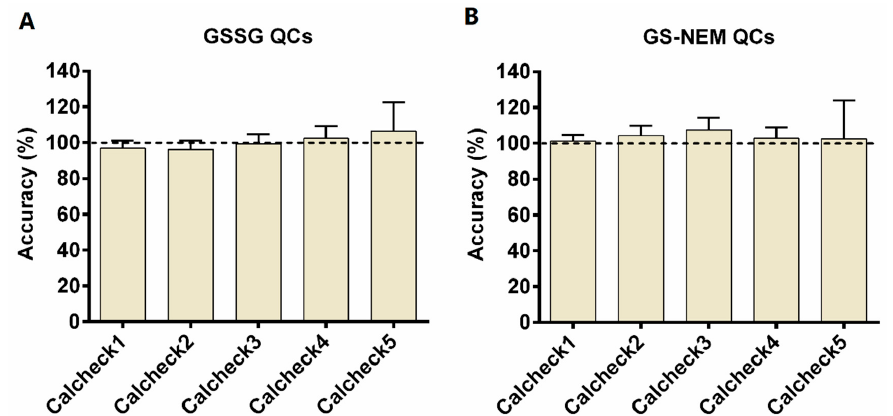
NEM and GSSG, respectively.